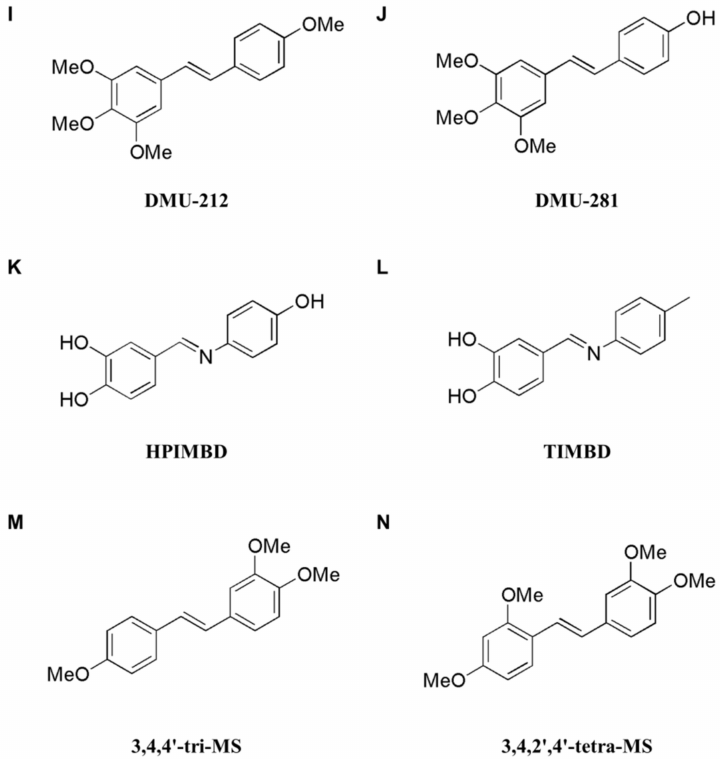
Figure 4. Structures of synthetic resveratrol analogues. ( A ) TMS2, ( Z )-3,4,5,4 (cid:48) - trans -tetramethoxystilbene. ( B ) SS28, ( E )-1,2,3-trimethoxy-5-(4-methylstyryl)benzene. ( C ) compound 1, ( E )-4,4 (cid:48) -(ethene-1,2-diyl)bis (3-methylphenol). ( D ) TRES, 3,5,4 (cid:48) -tri- O -acetyl-trihydroxystilbene. ( E ) 3,4,4 (cid:48) -THS, 3,4,4 (cid:48) -trihydroxy- trans -stilbene. ( F ) DHS, 4,4 (cid:48) -dihydroxy- trans -stilbene. ( G ) HS-1793, 4-(6-hydroxy-2-naphthyl)-1,3-benzenediol. ( H ) DIG, 3,5- O -digalloyl-resveratrol. ( I ) DMU-212, 3,4,4 (cid:48) ,5-tetramethoxystilbene. ( J ) DMU-281, 4-hydroxy -3,4,5-trimetoxystilbene. ( K ) HPIMBD, 4-( E )-{(4-hydroxyphenylimino)-methylbenzene, 1,2-diol}. ( L ) TIMBD, 4-( E )-{(p-tolylimino)-methylbenzene-1,2-diol}. ( M ) 3,4,4 (cid:48) -tri-MS, 3,4,4 (cid:48) -trimethoxy- trans -stilbenes. ( N ) 3,4,2 (cid:48) ,4 (cid:48) -tetra-MS, 3,4,2 (cid:48) ,4 (cid:48) -tetramethoxy- trans -